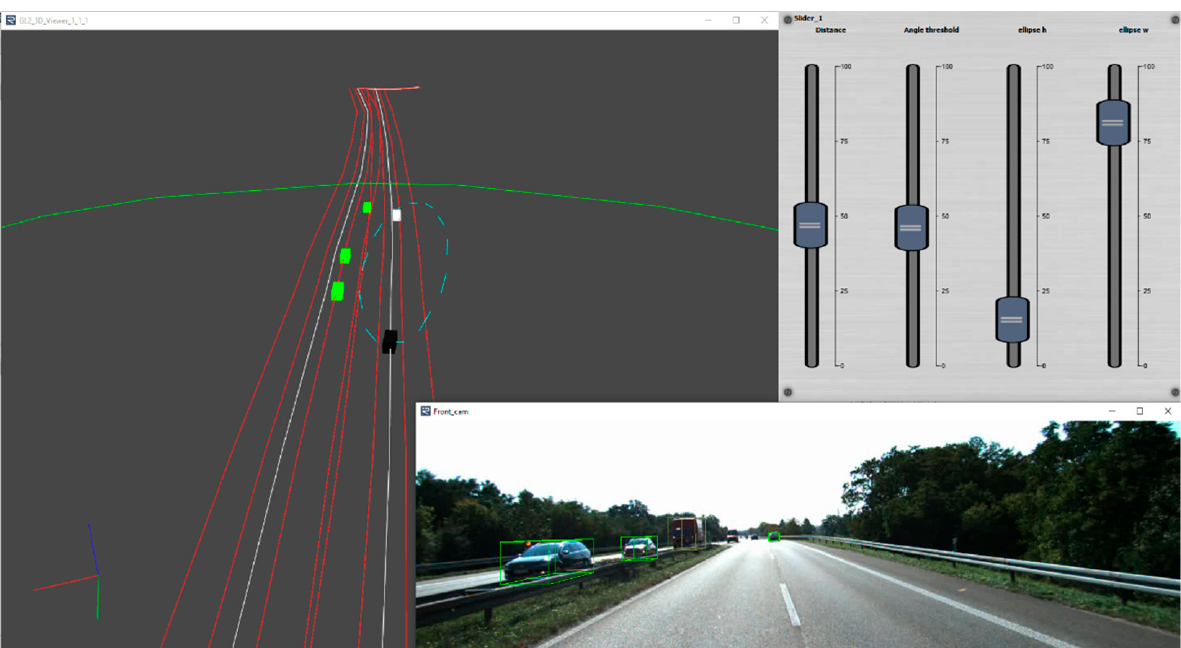
Figure 12. Visualisation in RTMaps of a given frame from a KITTI sequence while using the VDS function querying the iLDM. In the top right corner, the GUI with sliders to modify the different VDS input parameters can be seen.